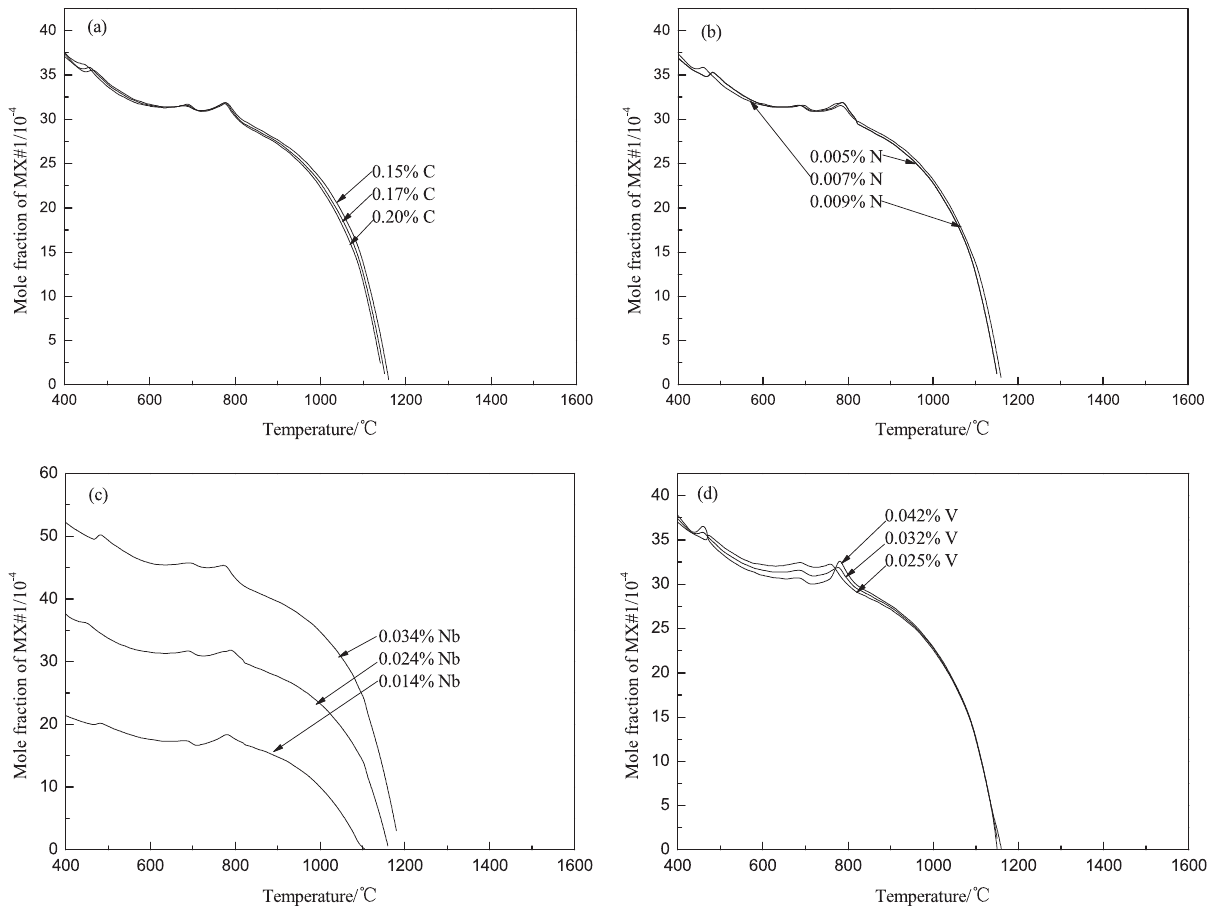
Fig. 4: The effect of alloy elements on the relationship between MX (mole fraction) and temperature: (a) C; (b) N; (c) Nb; (d)